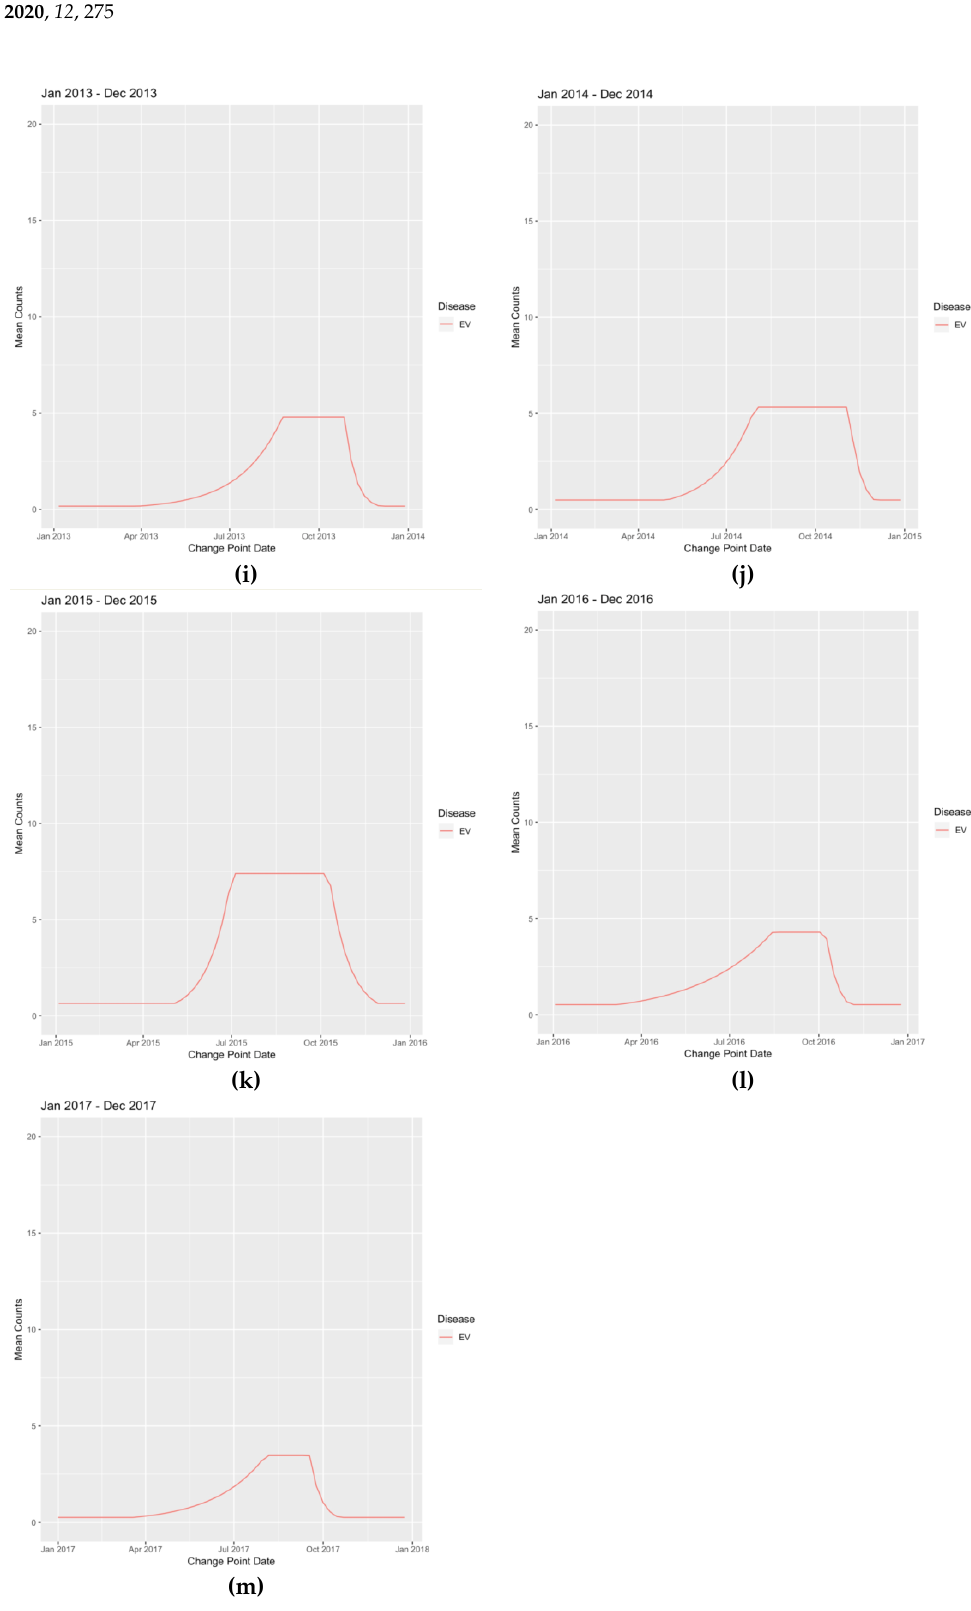
Figure A2. EV change point plots: for 2005 ( a ) through 2017 ( m ) Mean count of monthly timing of positive viral samples for enterovirus. Note that these charts follow a Jan-Dec seasonal cycle due to enterovirus mainly being a summer-fall peak seasonal virus.